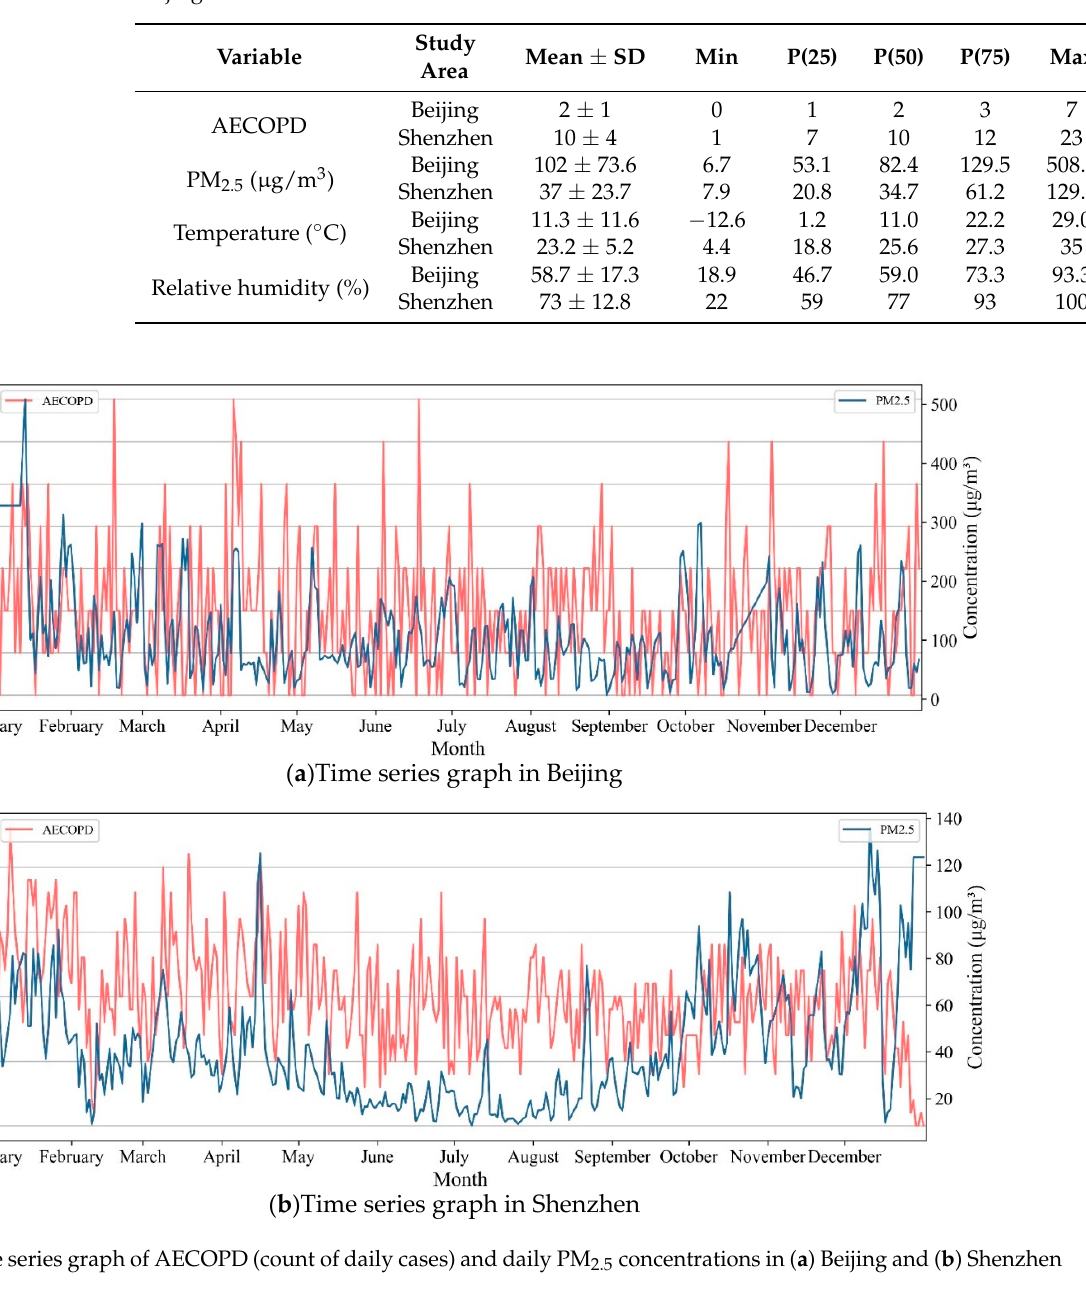
Table 1. The statistical characteristics of AECOPD, PM 2.5 concentration and meteorological factors in Beijing and Shenzhen in 2013.